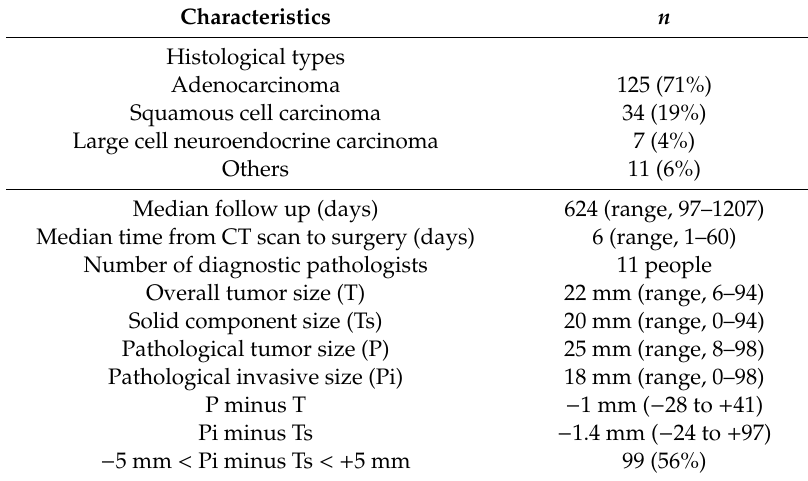
Table 1. Clinicopathological characteristics of